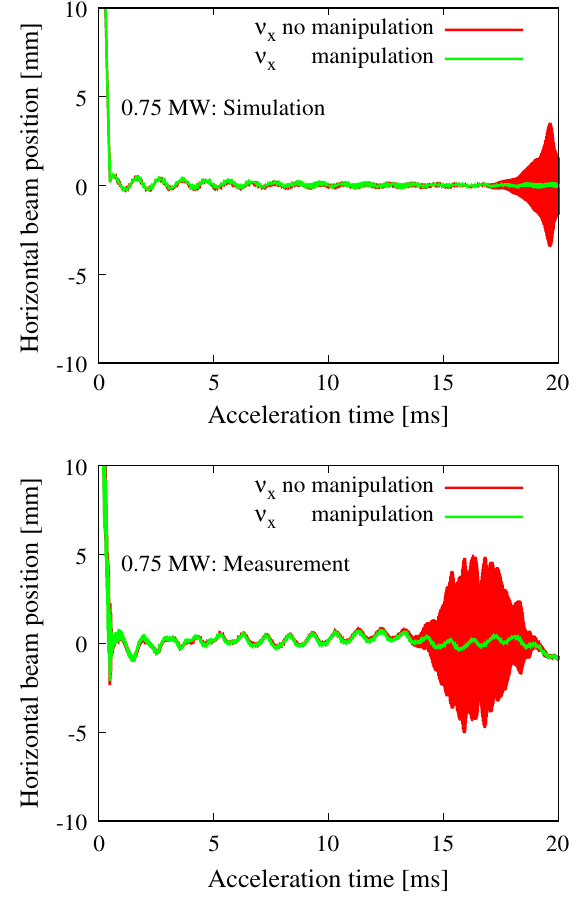
FIG. 20. Simulated (top) and measured (bottom) results of beam instability growth at a beam power of 0.75 MW. The beam instability, which occurs without any tune manipulation, can be well mitigated by applying a proper tune manipulation.